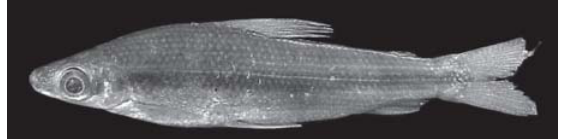
Fig. 4. Laemolyta fernandezi , CAS 116126, holotype, 73.1 mm SL; Venezuela, upper río